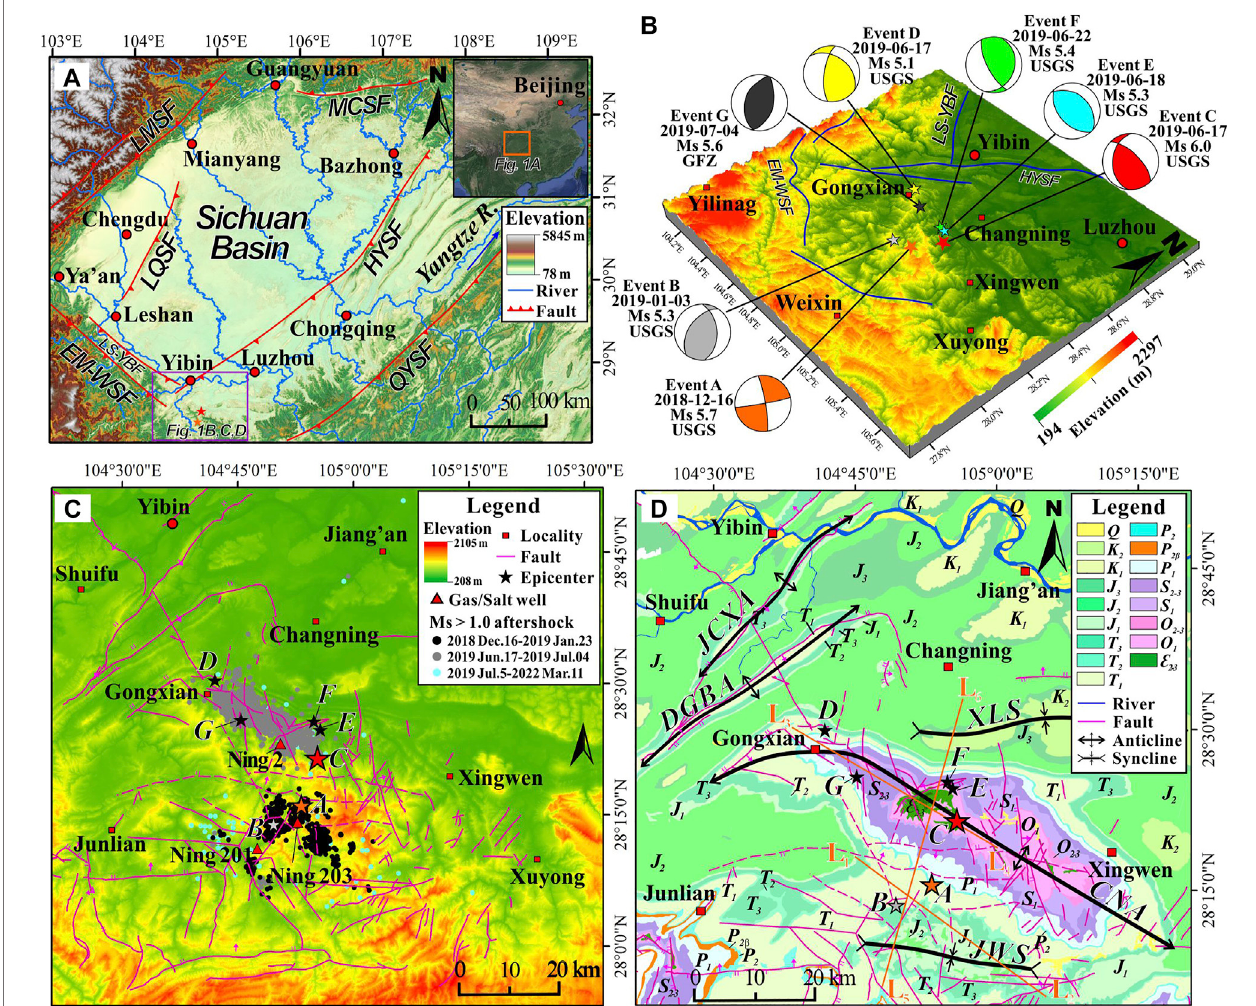
FIGURE1 |(A) Simpli fi edtopographical and tectonic map oftheSichuan Basin. MCSF : Micangshan fault; LMSF :Longmenshan fault; LQSF :Longquanshan fault; HYSF :Huayingshanfault; QYSF :Qiyaoshanfault; EM-WSF :Emei-Washanfault; LS-YBF :Leshan-Yibinfault. (B) Topographicmapandfocalmechanismsolutionsofthe Ms5.7Xingwenmainshock(EventA,orangestar)withitslargestaftershock(EventB,greystar)andtheMs6.0Changningmainshock(EventC,redstar)withitsMs > 5.0 aftershocks (Events D-G, other stars). (C) Topography and EQ information with faults in the study area. Stars indicate the epicenters of Events A-G. The dark, gey, andlightbluedotsrefertotheMs > 1.0aftershocks(Leietal.,2019a;Huetal.,2020;Longetal.,2020;CENC,2022).Faultdataarederivedfroma1:200,000geological map and Long etal.(2020). (D) Geologicalmap. CNA,Changninganticline; DGBA, Dengganba anticline; JCXA, Jiacunxianticline;JWS,Jianwusyncline; XLS,Xiangling syncline. Q, Quaternary; K 2 , Upper Cretaceous; K 1 , Lower Cretaceous; J 3 , Upper Jurassic; J 2 , Middle Jurassic; J 1 , Lower Jurassic; T 3 , Upper Triassic; T 2 , Middle Triassic;T 1 ,LowerTriassic;P 2 ,UpperPermian;P 2 β ,UpperPermianEmeishanbasalt;P 1 ,LowerPermian;S 2-3 ,MiddletoUpperSilurian;S 1 ,LowerSilurian;O 2-3 ,Middle to Upper Ordovician; O 1 , Lower Ordovician; Є 2-3 , Middle to Upper Cambrian. Pro fi les L 1 – L 2 and L 3 – L 4 are displayed in Figure 6 , and Pro fi le L 5 – L 6 is displayed in Figure 7